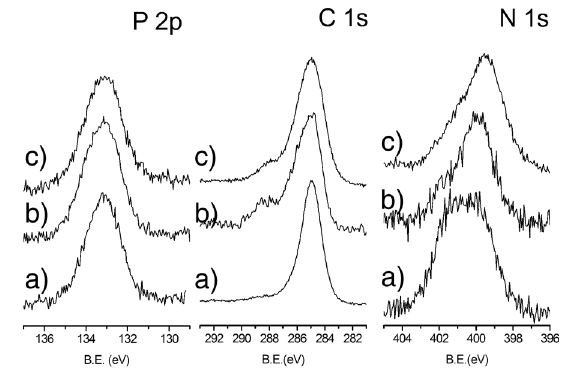
Fig. 3 XPS characterization of functionalized MNPs. High-resolution P 2p, C 1s, and N 1s XPS spectral regions of a) NH 2 @MNPs, b)